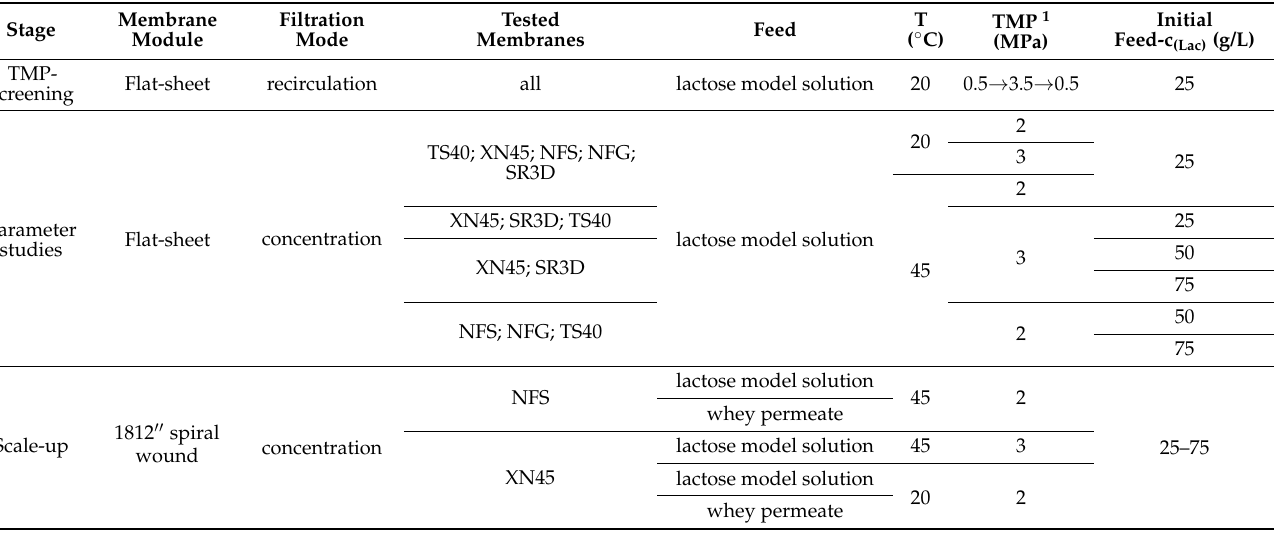
Table 3. Overview of parameter settings and membrane used for experimental